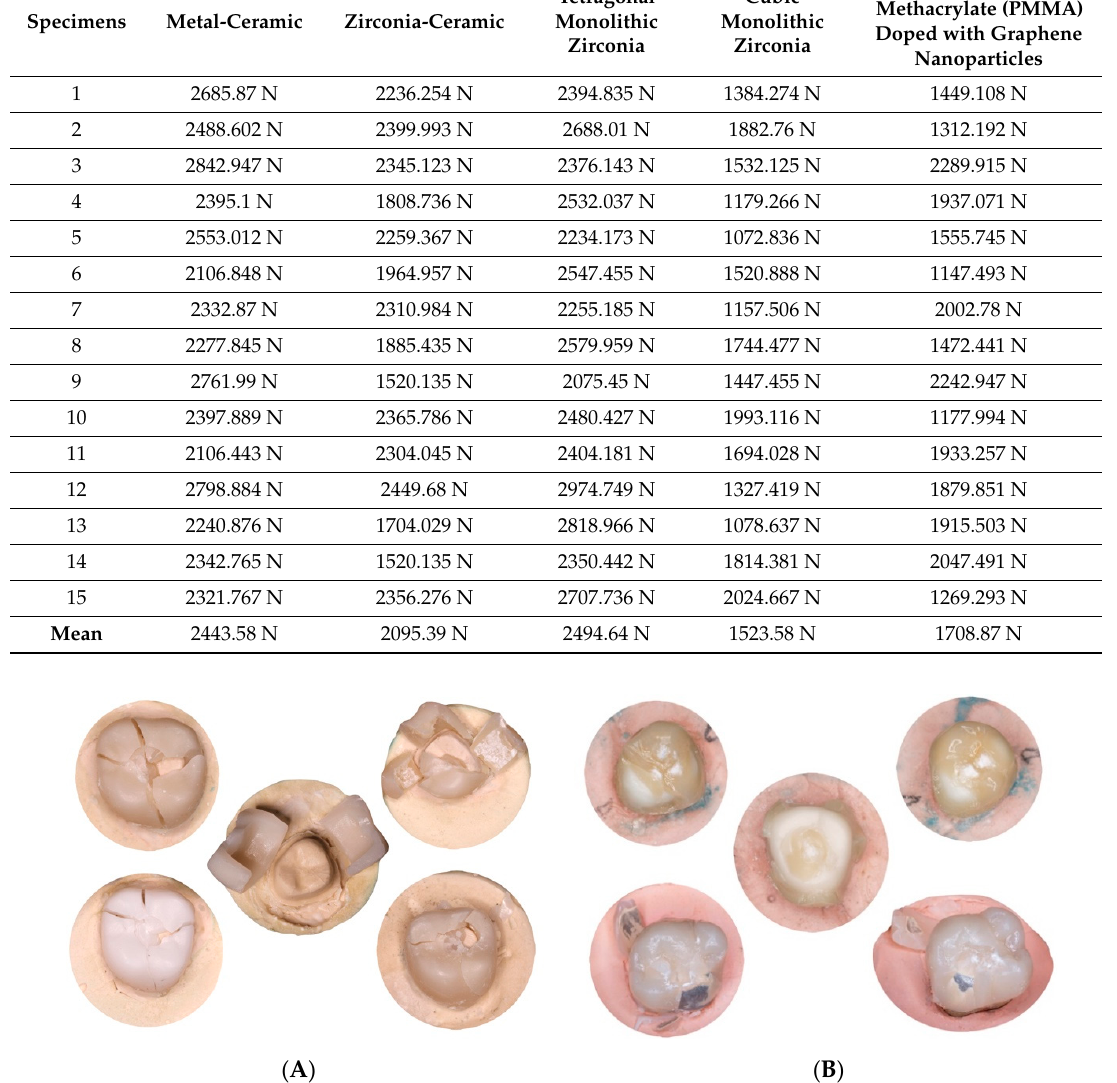
Figure 3. Crowns fractured after compression testing. ( A ) Monolithic crowns; ( B ) non-monolithic crowns.